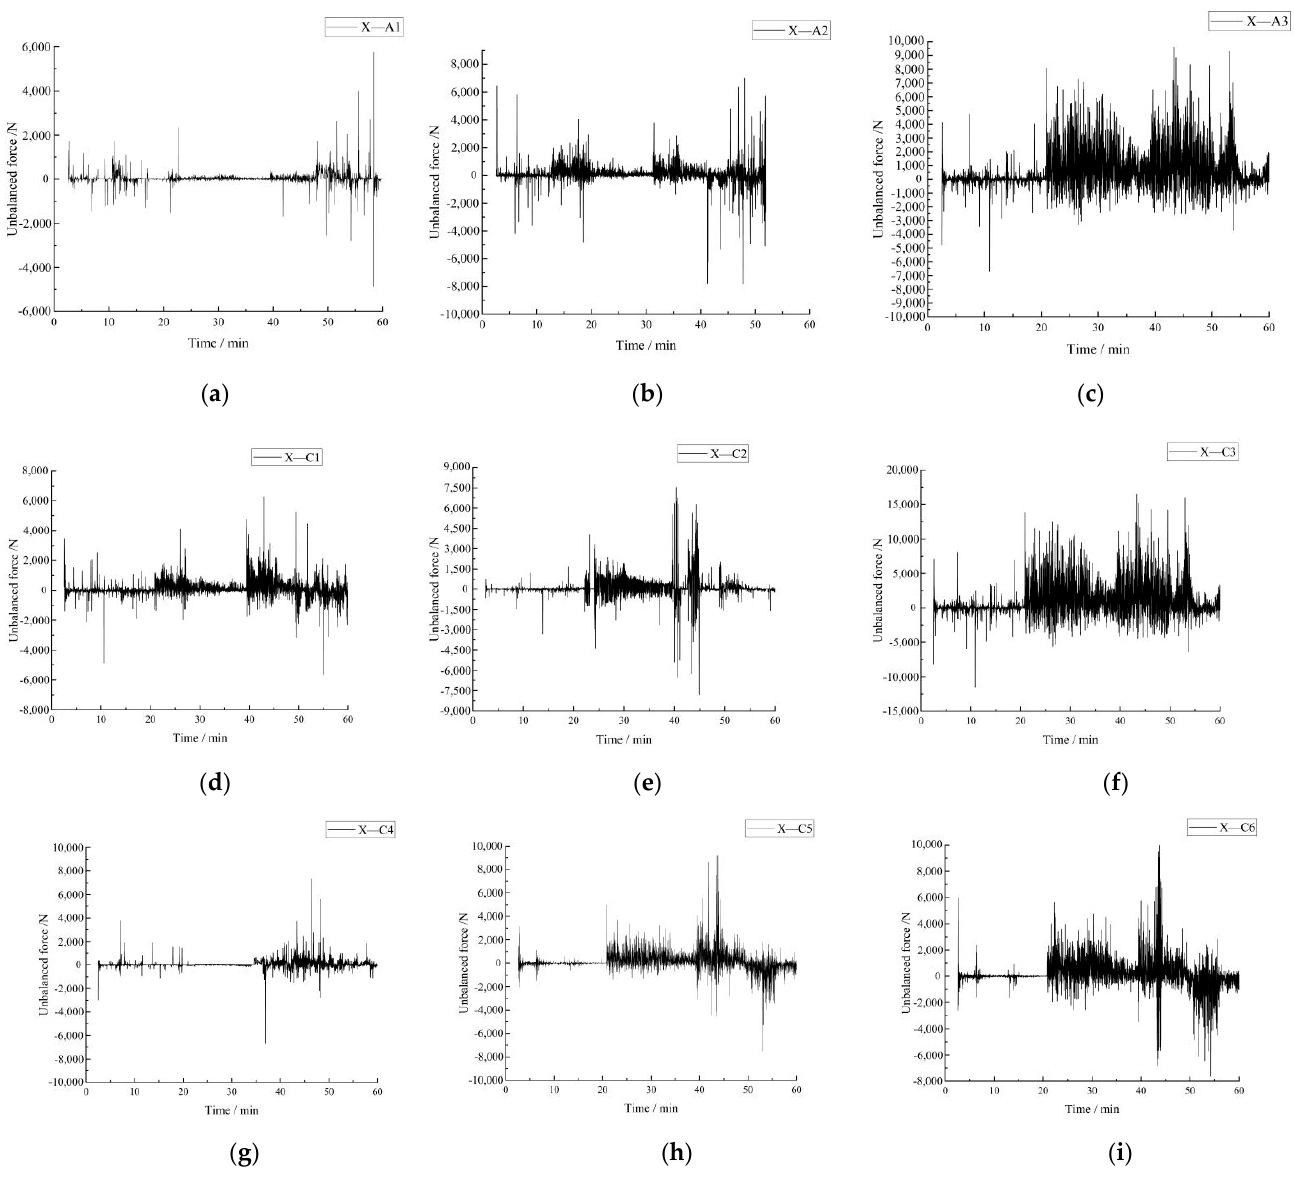
Figure 16. Unbalanced force curves. ( a ) Monitoring point A1 ( b ) Monitoring point A2 ( c ) Monitoring point A3 ( d ) Monitoring point C1 ( e ) Monitoring point C2 ( f ) Monitoring point C3 ( g ) Monitoring point C4 ( h ) Monitoring point C5 ( i ) Monitoring point C6.